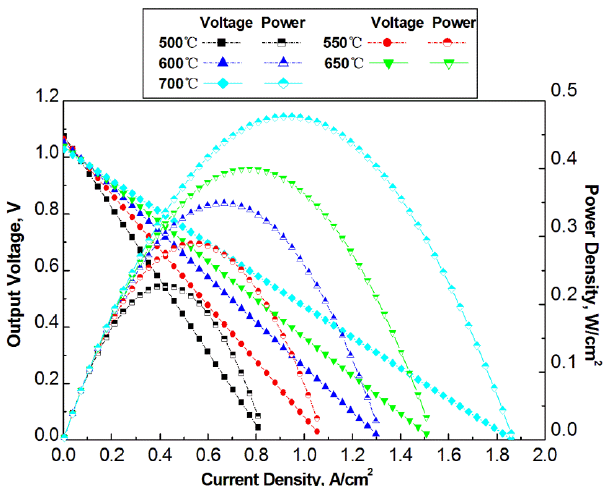
= 3 mm; rib ratio R = o Lc